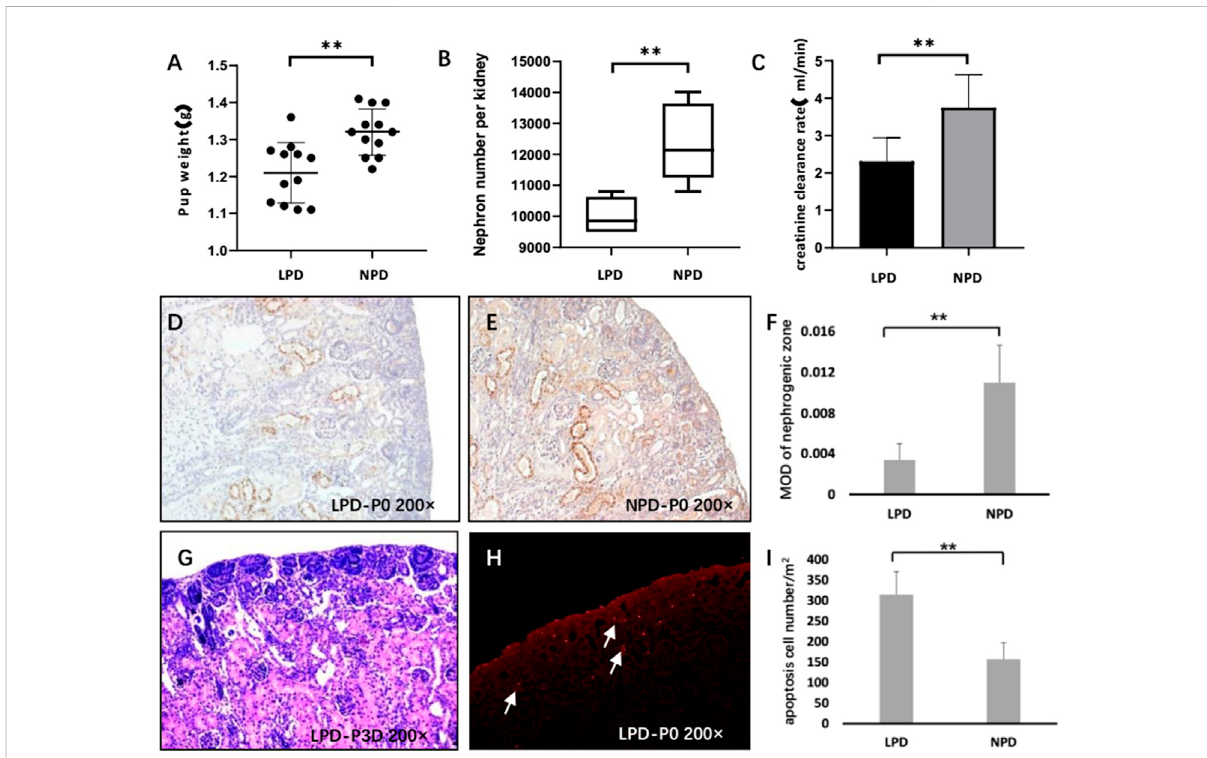
FIGURE 1 EndorepellinisdownregulatedintheIUGRrodentmodel. (A) Thepupweightofthematernallow-proteindiet(LPD)groupatbirthissigni fi cantly lower than that of thematernal normal-proteindiet (NPD) group in mice ( n = 12). (B) LPD reduces thenephron number inthe kidney compared with NPD ( n = 12). (C) After the 12-week follow-up, LPD mice showed decreased creatinine clearance rate (n = 8) (D,E) Representative kidney tissue sectionsstainedwithendorepellinatbirth. (F) DensitometryanalysisofDVimmunohistochemistryinthenephrogeniczoneasshowninDandE ( n = 8). (G) HE staining showed that there were still many nephrons in the process of formation in 3-day postnatal mice. (H) Representative TUNEL imageshows signi fi cant cellapoptosisinthenephrogenic zoneofLPDnewborn mice. (I) Apoptosisassessmentofthenephrogenic zoneinLPDand NPD newborn mice ( n = 8). LPD, low-protein diet; NPD, normal-protein diet; DV, endorepellin; HE, hematoxylin – eosin staining; and TUNEL, TdT- mediated dUTP Nick-End Labeling. ** p <